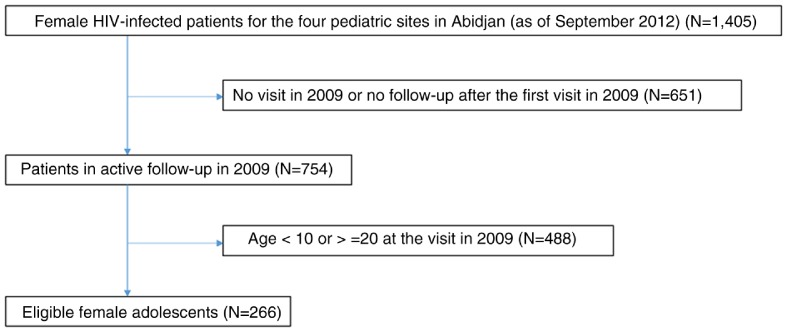
Flow chart of HIV-infected female adolescents eligible for the analysis.